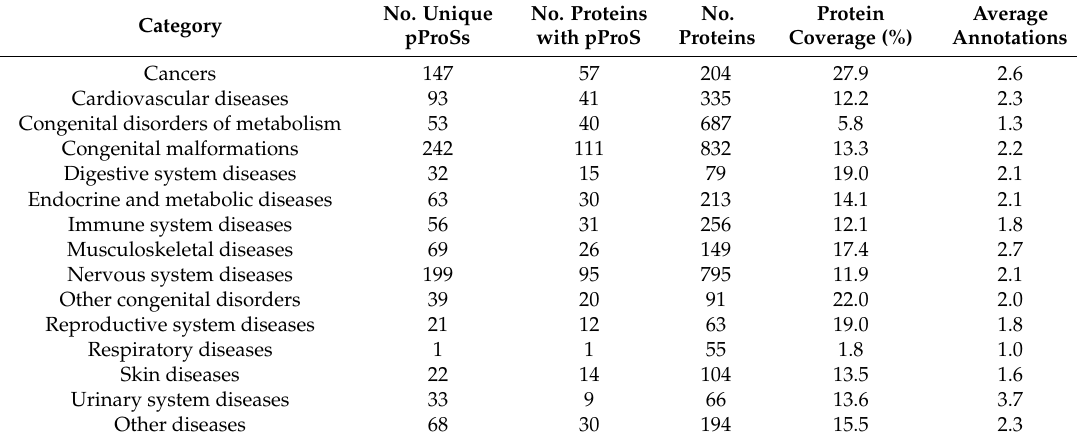
Table 2. Statistics of pProS by the disease